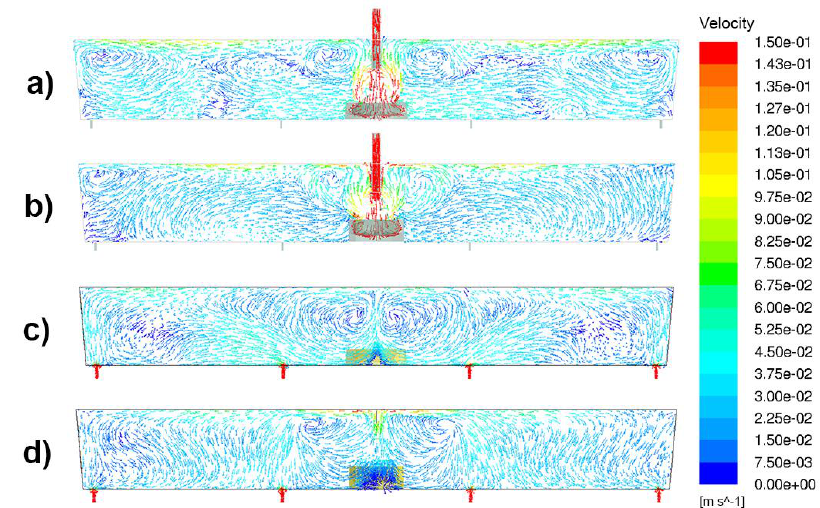
Figure 11. Velocity fields in vertical planes passing through the axis of the ladle shroud: ( a ) TI1 and ( b ) TI3. Velocity fields in planes passing through the four strands: ( c ) TI1; ( d ) TI3.